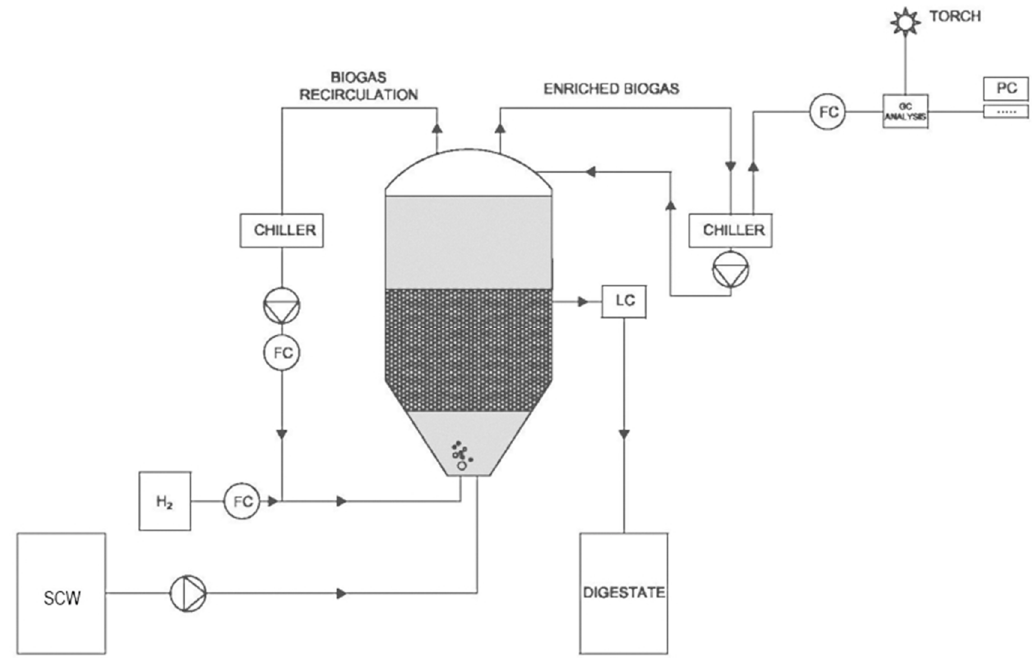
Figure 1. Schematic representation of the hybrid gas-stirred tank reactor (GSTR) and the experimental equipment. LC, liquid control; FC, flow control; SCW, second cheese whey.